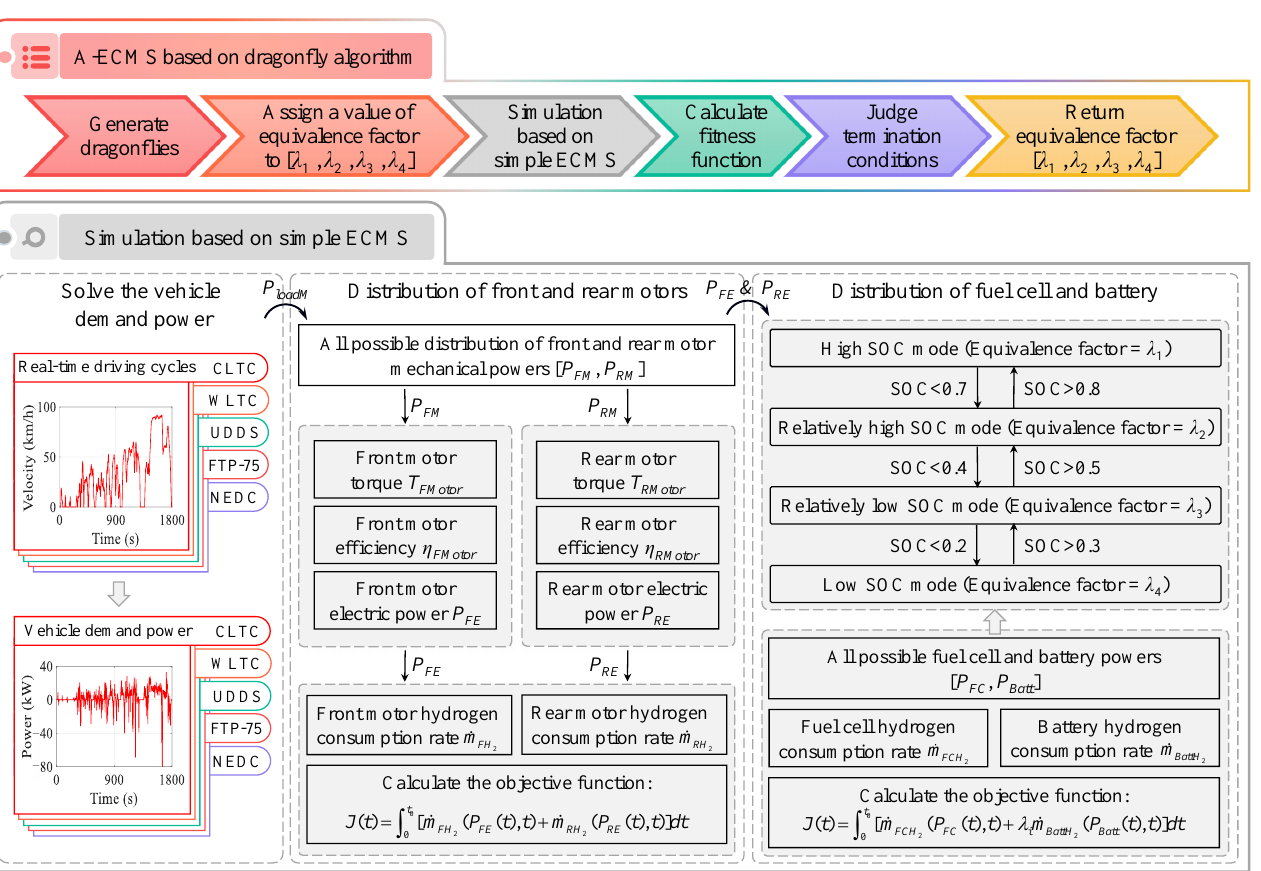
Figure 5. A-ECMS EMS based on dragonfly